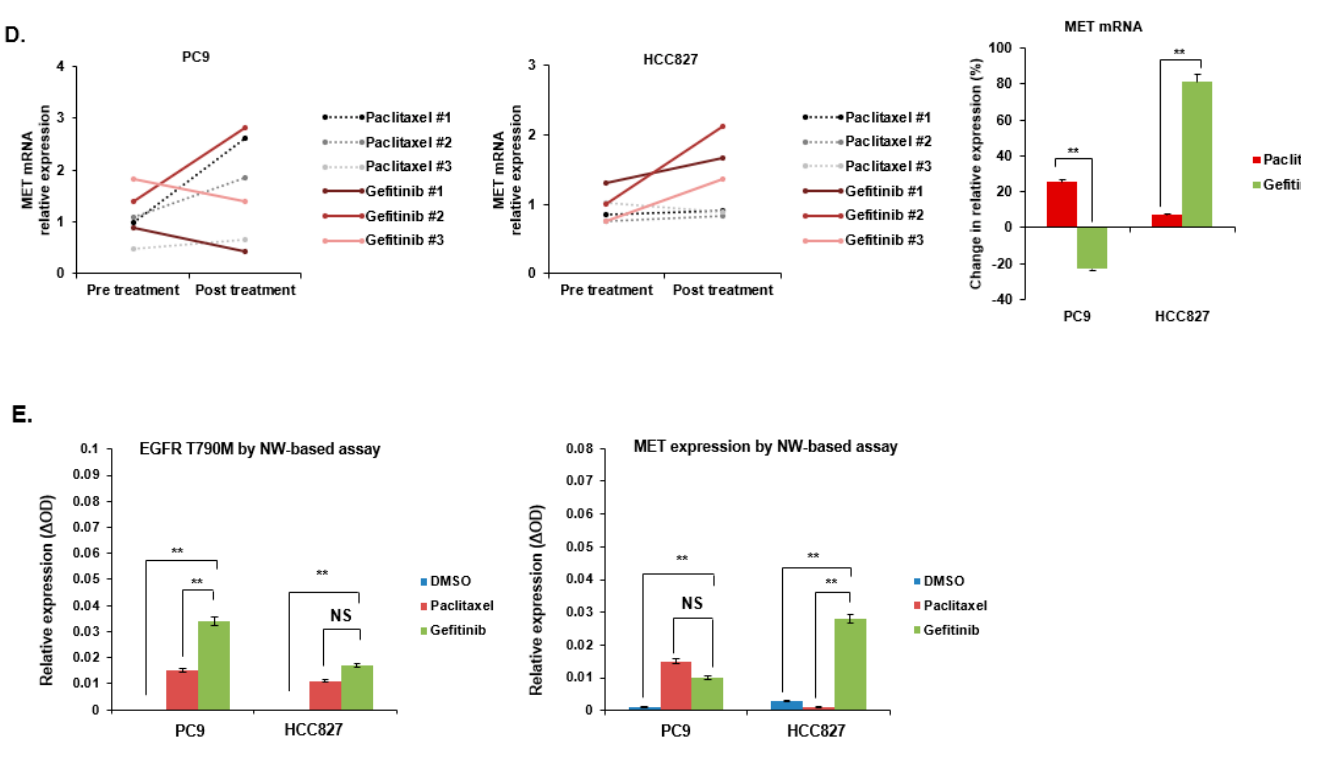
Figure 4. Expression of specific gene alterations related to EGFR-TKI resistant mechanism in vivo. ( A ) Schematic diagram of xenograft experiments. ( B , C ) EGFR T790M mutation changes in each sub-cutaneous PC9 or HCC827 xenograft tumor after gefitinib or paclitaxel treatment. The T790M mutation allele frequency was measured using the ddPCR assay. The dotted line indicates the threshold for EGFR T790M mutation detection (0.05%). ( D ) Change in the C-MET mRNA expression level in each subcutaneous PC9 or HCC827 xenograft tumor after gefitinib or paclitaxel treatment. C-MET mRNA expression was measured by RT-PCR. ( E ) The levels of EGFR T790M mutation and C-MET expression were measured using the nanowire-based (NW) colorimetric assay. Error bars represent the mean ± SEM. Statistical analysis was performed using t-test. ** p ≤ 0.05; NS, not significant.